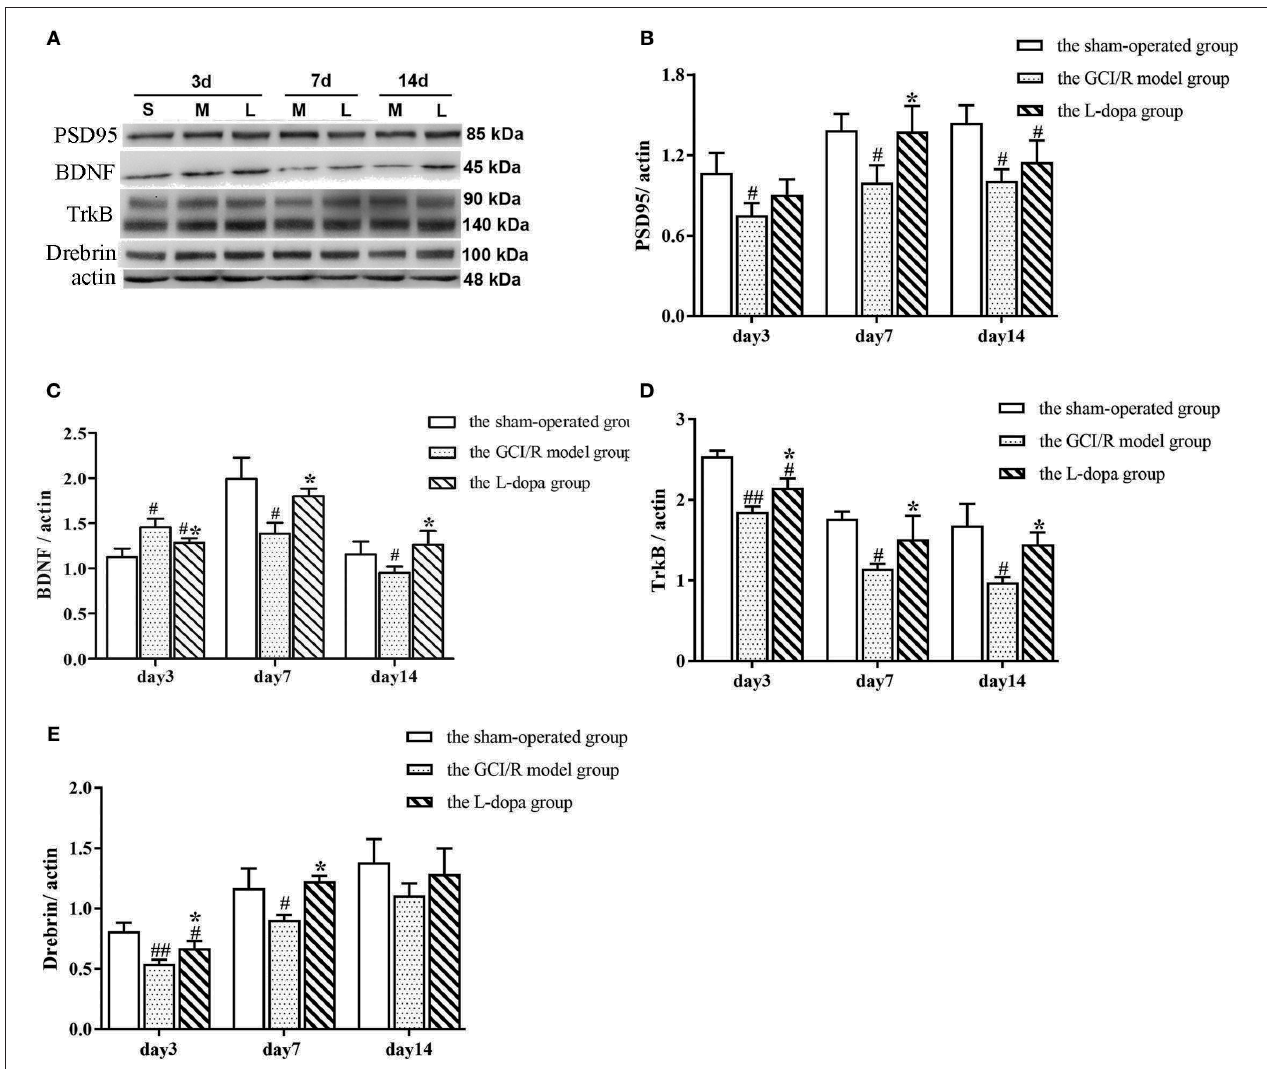
FIGURE 8 | Western blot analysis of the expression of synaptic plasticity related proteins in hippocampal tissues. (A) The expression of PSD95, BD NF, TrkB, Drebrin proteins in hippocampus. (B) The expression of PSD95 (B) , BDNF (C) , TrkB (D) , and Drebrin (E) in the hippocampus at 3, 7, and 14 days after GCI/R injury. Data are shown as means ± SD. ##p < 0.01 vs. the sham operated group. # p < 0.05 vs. the sham operated group, * p < 0.0 5 vs. the GCI/R model